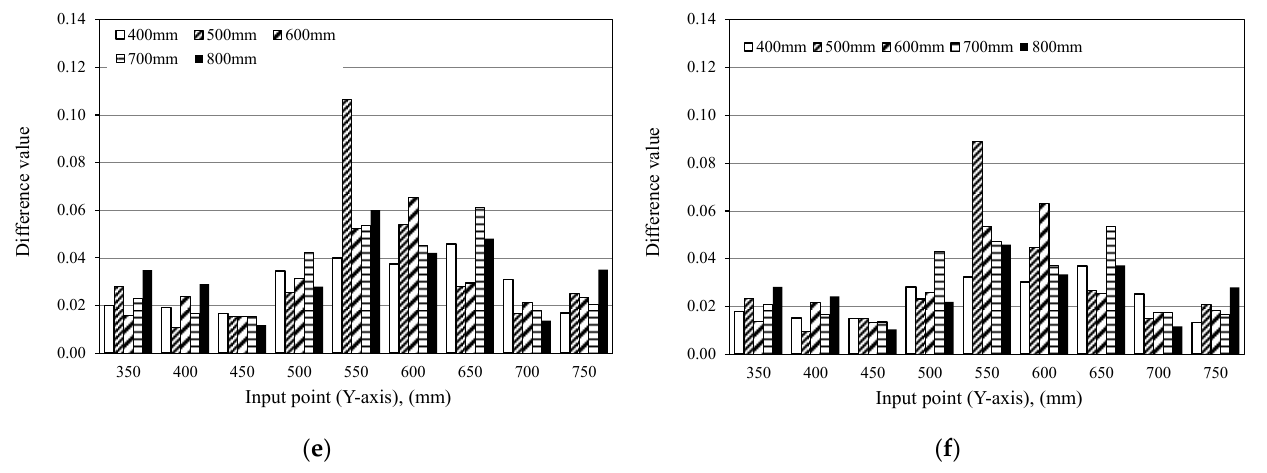
Figure 14. DVA results for Case_2 ( φ S : 63 mm, Depth: 137 mm): ( a ) N = 100; ( b ) N = 250; ( c ) N = 500; ( d ) N = 1000; ( e ) N = 1500; ( f ) N = 2000.